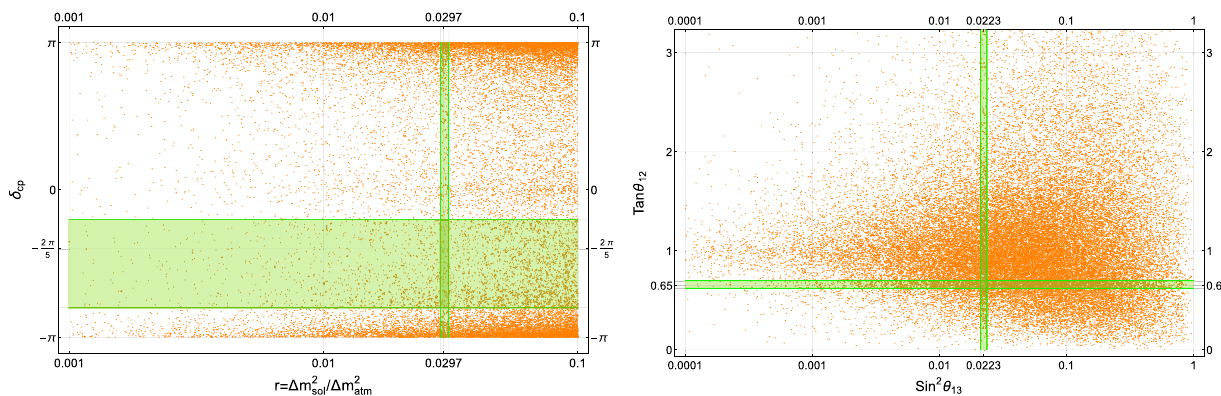
Fig. 1 Scatter plots of the physical observables as predicted by our model. Left panel: scatter plot in the ( r ,δ cp ) plane. Right panel: scatter plot in the ( sin θ 132 , tan θ 12 ) plane. The green bands display the 2 σ C.L. for the oscillation parameters [2] Fig. 2 | m ee | as a function of the lightest mass m 3 . The shaded area corresponds to the region allowed by current neutrino data, for a mass ordering of inverted type. The vertical band corresponds to the current sensitivity on the lightest neutrino mass of 0.2 eV from the KATRIN experiment [22] and the horizontal line to